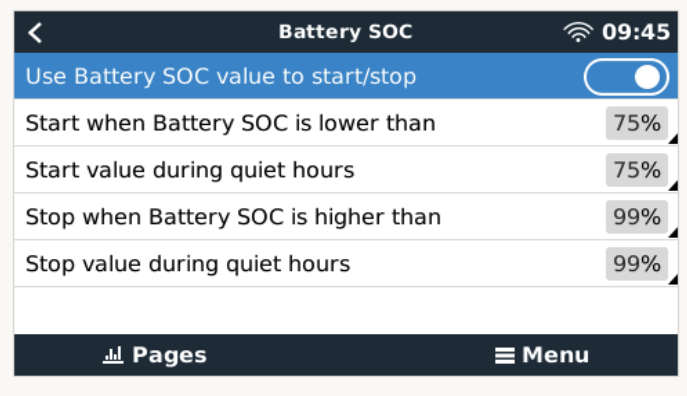
Figure 18. Condition configuration based on SOC.